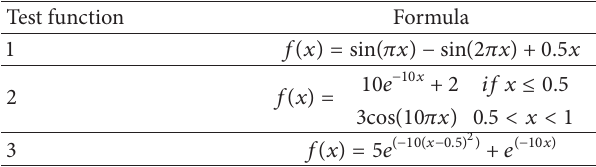
Table 1: Formula of the test functions used in the simulation.